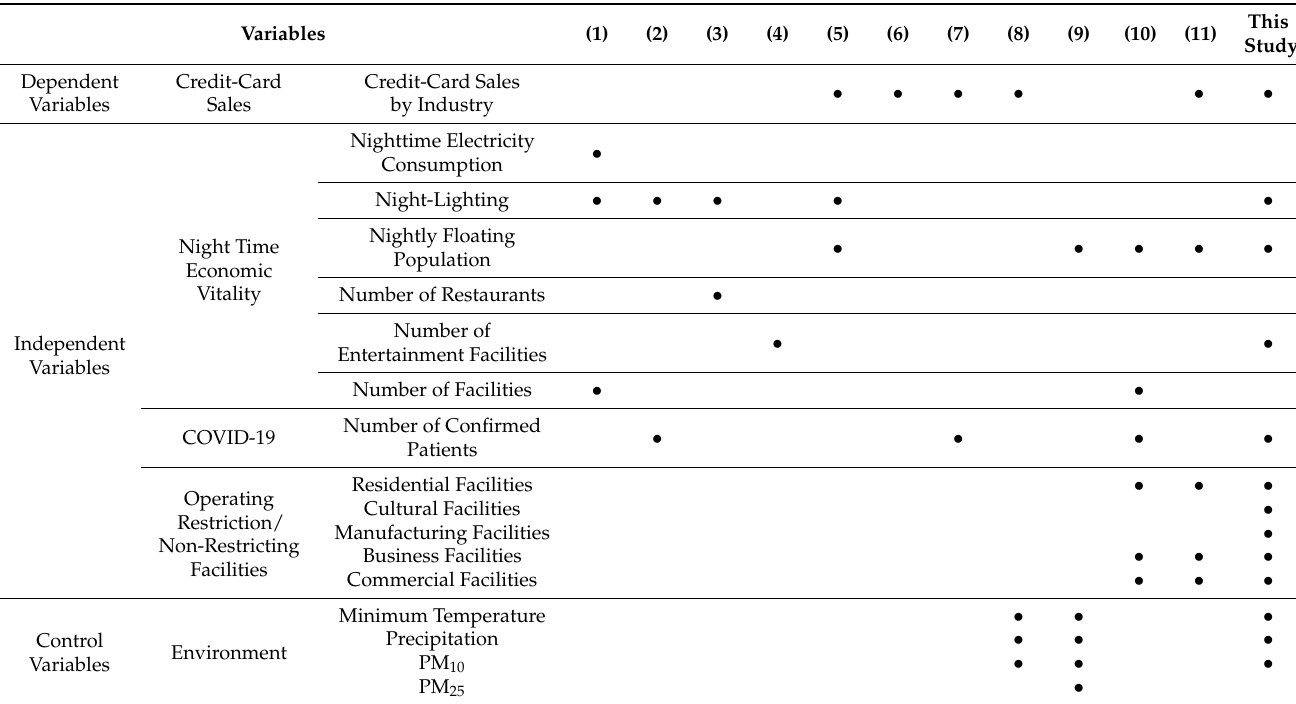
Table 1. Variables used in previous